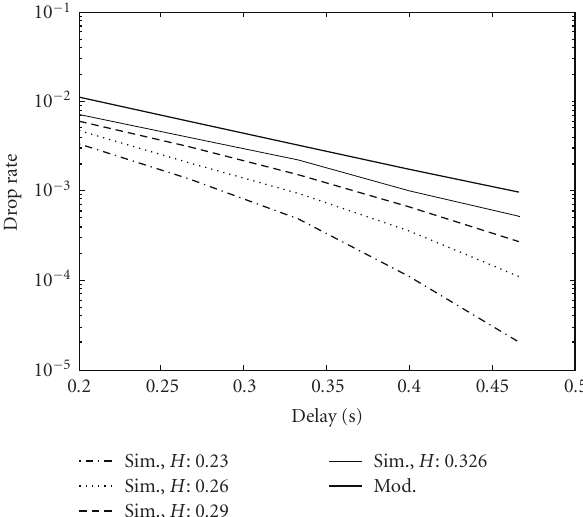
Figure 16: Data drop rate versus bu ff ering delay estimated by the model (Mod) and measured by simulation (Sim) for 2 di ff erent groups of bit streams in terms of Hurst exponent and σ/μ .